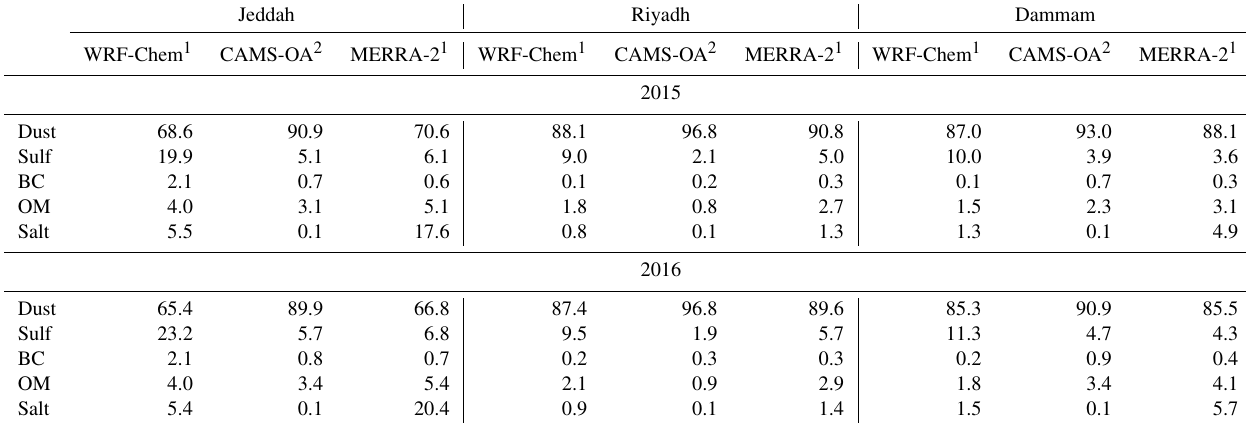
Table 6. Contributions (%) of dust and nondust components to PM 2 . 5 for Jeddah, Riyadh, and Dammam during 2015–2016. Jeddah